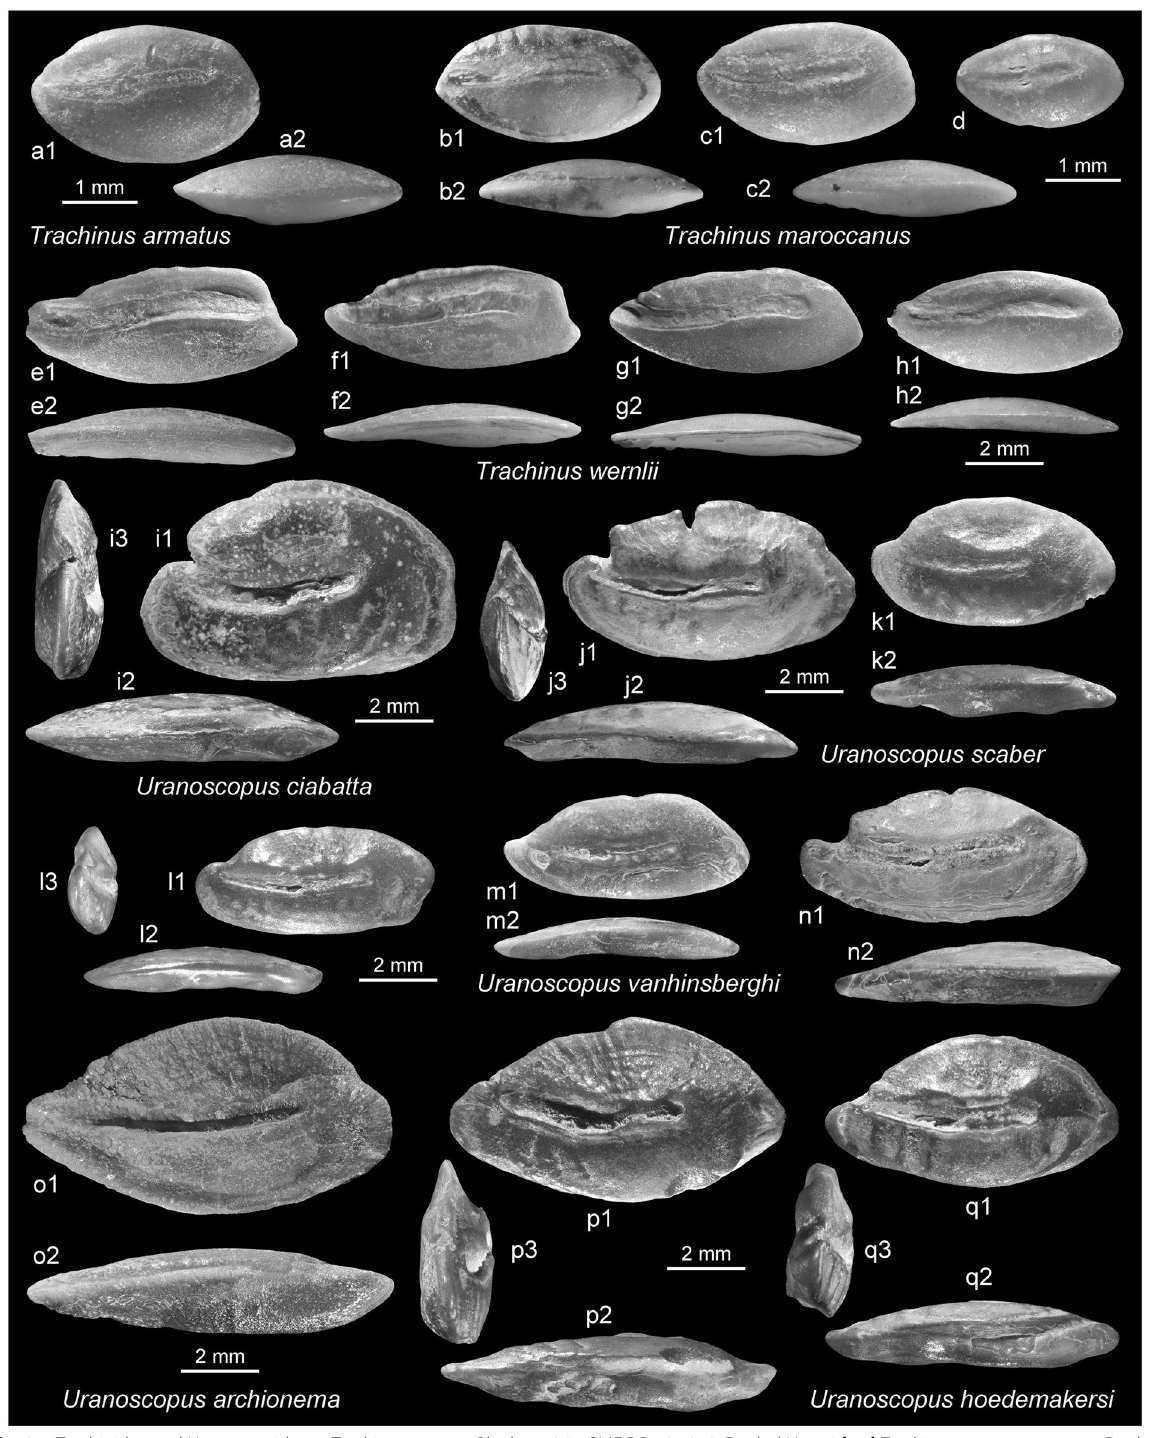
Fig. 25 Trachinidae and Uranoscopidae. a Trachinus armatus Bleeker, 1861, SMF PO 101.250, Dar bel Hamri. b – d Trachinus maroccanus n. sp., Dar bel Hamri, Zanclean, b holotype, SMF PO 101.251, c – d paratypes, SMF PO 101.252 (25c reversed). e – h Trachinus wernlii n. sp., Dar bel Hamri, Zanclean, 25 g holotype, SMF PO 101.253 (reversed), e – f , h paratypes, SMF PO 101.254 ( e , h reversed). i Uranoscopus ciabatta Girone et al., 2010, SMF PO 101.287, Dar bel Hamri. j – k Uranoscopus scaber Linnaeus, 1758, Dar bel Hamri, SMF PO 101.255 (reversed). l – n Uranoscopus vanhinsberghi n. sp., Dar bel Hamri, Zanclean, l holotype, SMF PO 101.256 (reversed), m – n paratypes, SMF PO 101.257 ( n reversed). o Uranoscopus archionema Regan, 1921, Madagascar (reversed). p – q Uranoscopus hoedemakersi n. sp., Dar bel Hamri, Zanclean, p holotype, SMF PO 101.258, q paratype, SMF PO